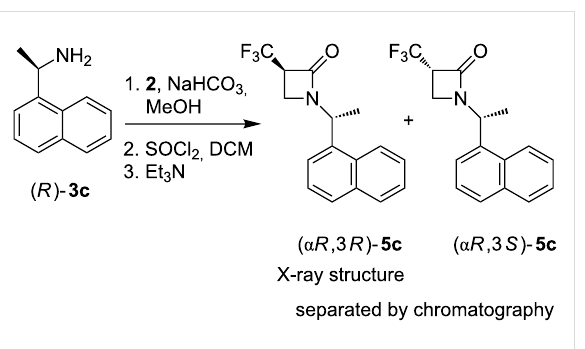
comparison of a racemic sample of 1 and then a sample after diastereoisomer separation of 5b as described above, indicated that β -lactam 1 was prepared in an enantiomerically pure